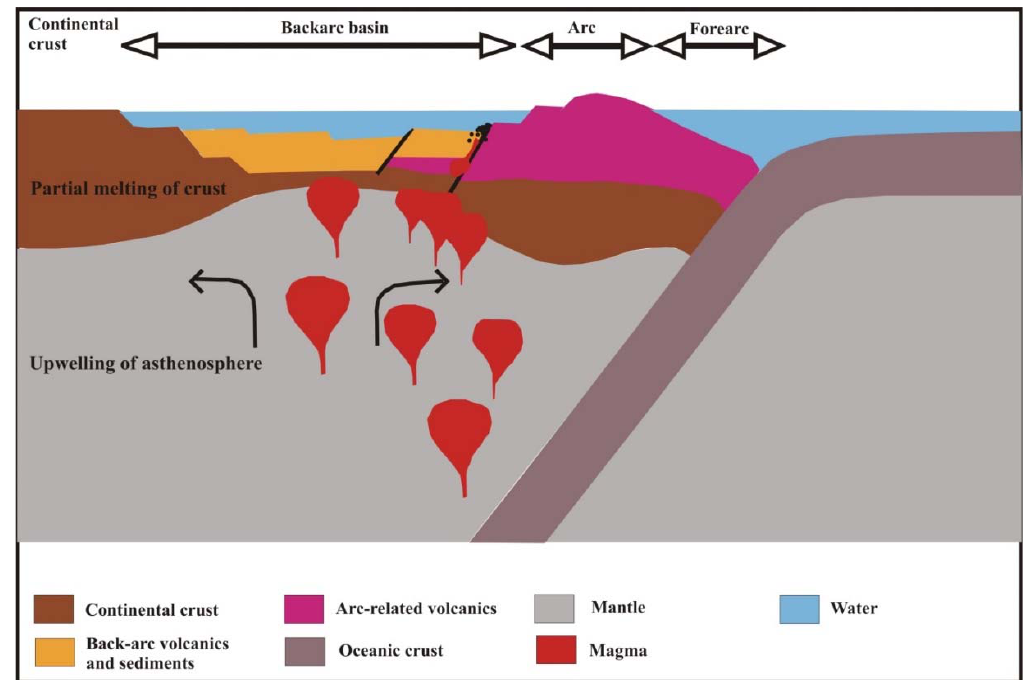
Figure 14. Schematic geodynamic model showing possible massive sulfide deposit of Mundiyawas-Khera copper deposit, i.e., Upwarping and rifting of continental crust due to upwelling of magma from asthenosphere in a back arc basin and partial melting of continental crust, disseminated sulfides (pyrite, pyrrhotite, chalcopyrite and arsenopyrite) deposit with syn-volcanic eruption and epigenetic copper mineralization due to circulation of hydrothermal fluids.